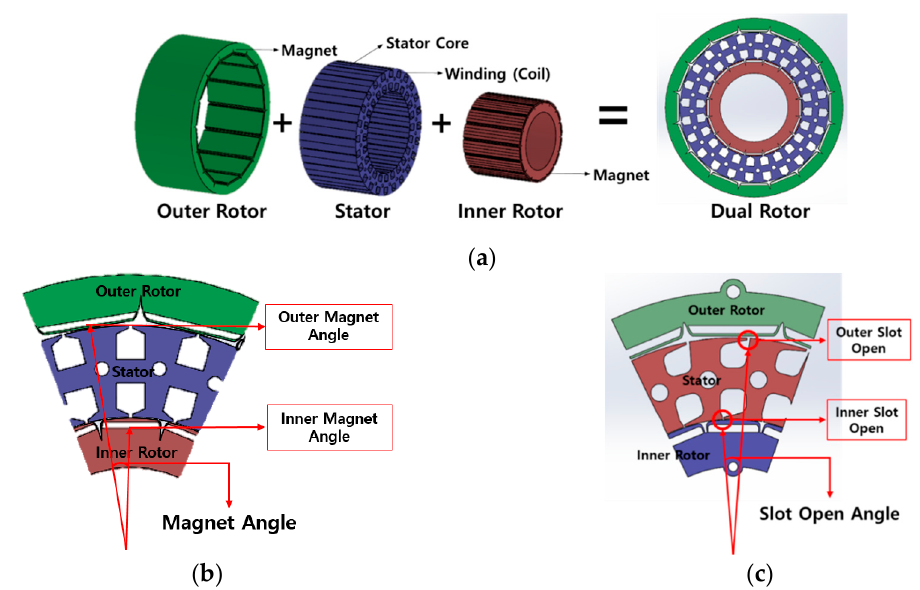
Figure 1. Dual rotor structure and cogging torque reduction method: ( a ) Dual rotor structure, ( b ) cogging torque reduction method according to magnet angle, ( c ) cogging torque reduction method based on adjustment of dual rotor slot opening angle.